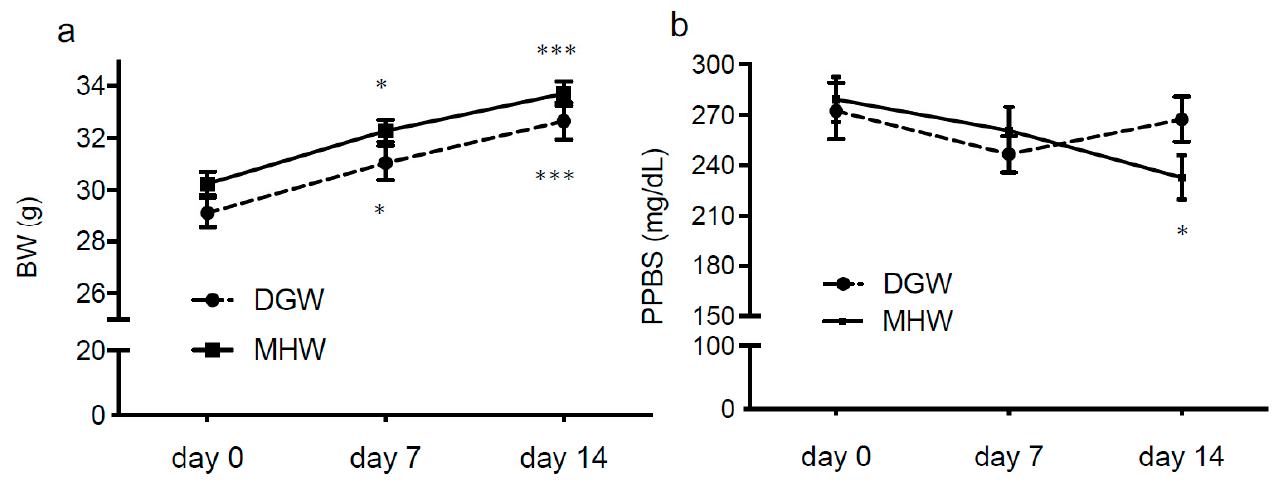
Figure 2. The transition of BW and PPBS in DIO mice treated with MHW vs. DGW for 2 weeks. BW ( a ) and PPBS ( b ) in DIO mice treated with MHW or DGW for 14 days. n = 12; * p < 0.05, ** p < 0.01, *** p < 0.001 vs. day 0 in each group.